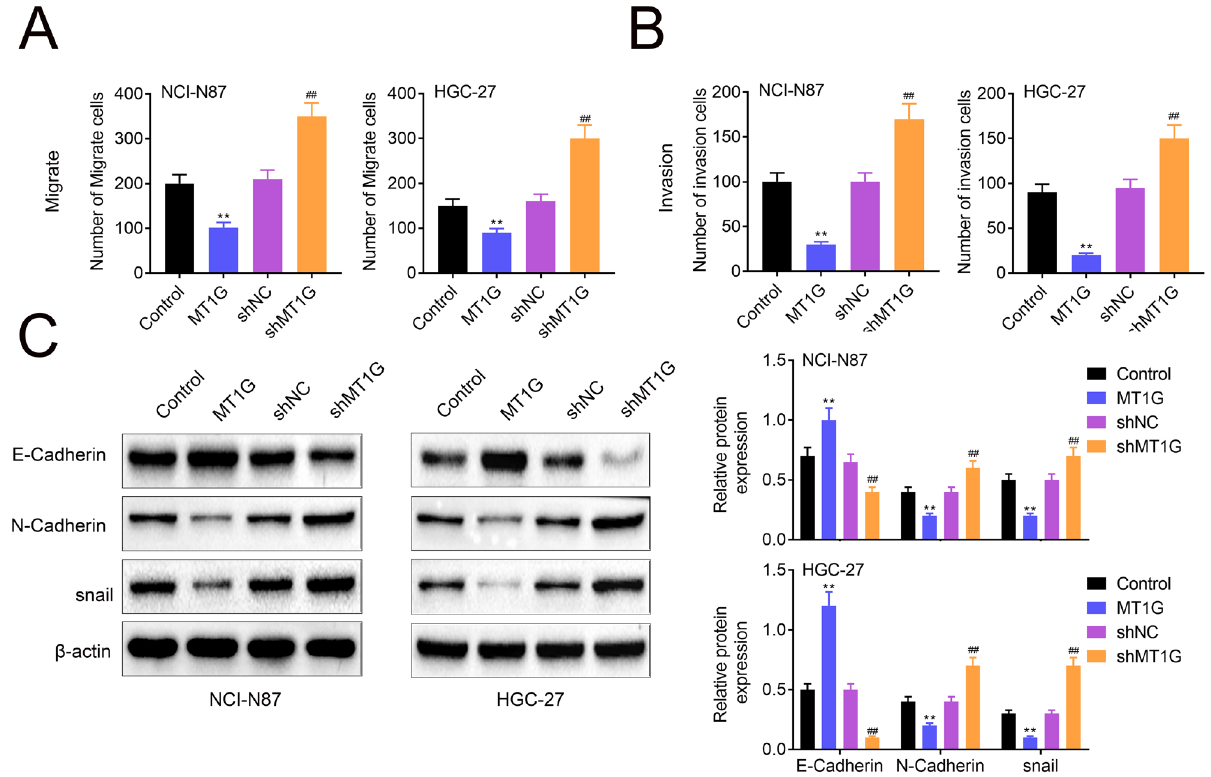
Figure 4 – MT1G negatively regulates cell migration and invasion. (A and B) Transwell assay and transwell matrigel assay were used to measure cell migration and invasion in MT1G overexpression or knockdown NCI-N87 and HGC-27 cells. (C) Western blotting analysis EMT related proteins